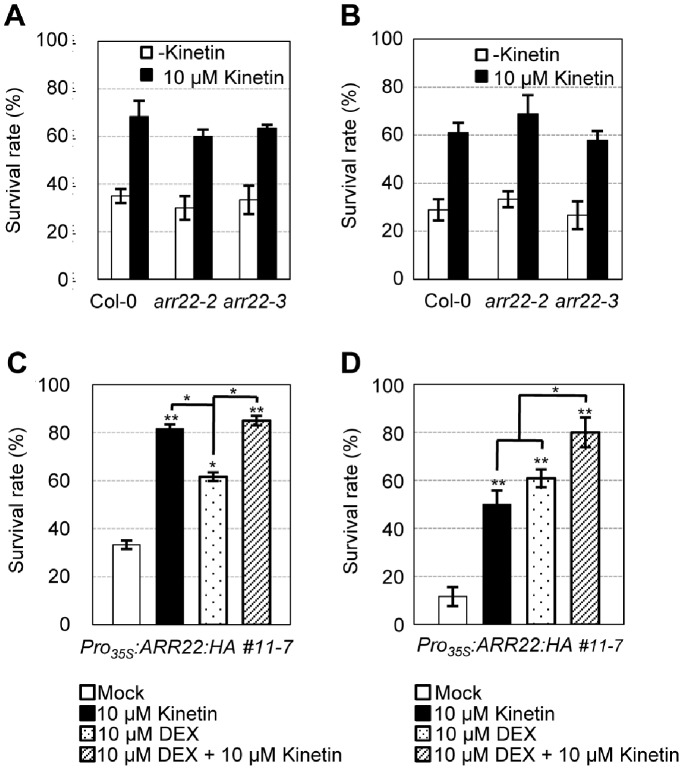
Effect of cytokinin preincubation on drought and freezing tolerance of arr22, Pro35S:ARR22:HA, and the wild-type plants.(A) Dehydration tolerance assays of arr22 mutants compared with the wild-type plants with or without cytokinin preincubation. Plants were grown for 7 d on Whatman 3MM filter placed on 0.5× MS agar plates, transferred to 0.5× MS agar plates with or without 10 µM kinetin, and grown for an additional 4 d. These plants were dehydrated for 4 h 30 min and recovered by 3 d of rehydration. Surviving plants after recovery were then counted. Mean values and standard errors from triplicate biological replications are plotted. Bars indicate standard errors. n = 20. (B) Freezing tolerance assays of arr22 mutants compared with the wild-type plants with or without cytokinin preincubation. Plants were grown for 7 d in the light, transferred to MS plates or MS plates containing 10 µM kinetin, and grown for an additional 4 d. These plants were subjected to freezing treatment at −5°C for 4 h. Plants that survived after incubation at 23°C for 3 d for recovery were counted. Experiments were conducted in triplicate, and mean values and standard errors are plotted; n = 30. (C) Dehydration tolerance assays of Pro35S:ARR22:HA with or without cytokinin preincubation. Plants were grown for 7 d on Whatman 3MM filter placed on 0.5× MS agar plates, transferred to 0.5× MS agar plates with or without 10 µM DEX, and grown for an additional 4 d with or without 10 µM cytokinin treatment. These plants were dehydrated for 5 h and recovered by 3 d of rehydration. Surviving plants after recovery were then counted. Mean values and standard errors from triplicate biological replications are plotted. Bars indicate standard errors. n = 20. (D) Freezing tolerance assays of Pro35S:ARR22:HA with or without cytokinin preincubation. Plants were grown for 7 d in the light, transferred to 0.5× MS plates with or without 10 µM DEX, and grown for an additional 4 d with or without 10 µM kinetin. These plants were subjected to freezing treatment at −5°C for 4 h. Plants that survived after incubation at 23°C for 3 d for recovery were counted. Experiments were conducted in triplicate, and mean values and standard errors are plotted; n = 30.